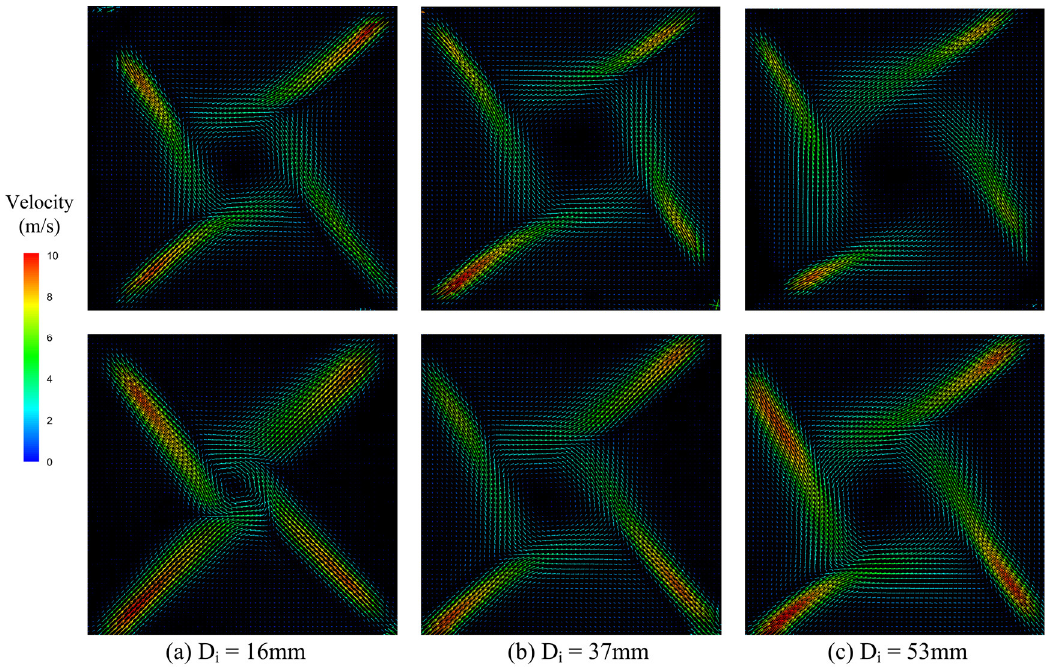
Figure 4. The velocity vector for gas ( top ) and particles ( bottom ) on cross-section under three different ideal tangential diameters.